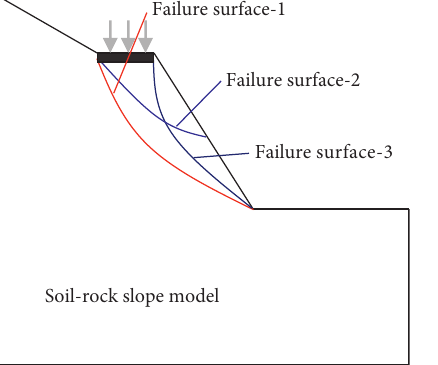
Figure 19: Three typical failure modes in soil-rock